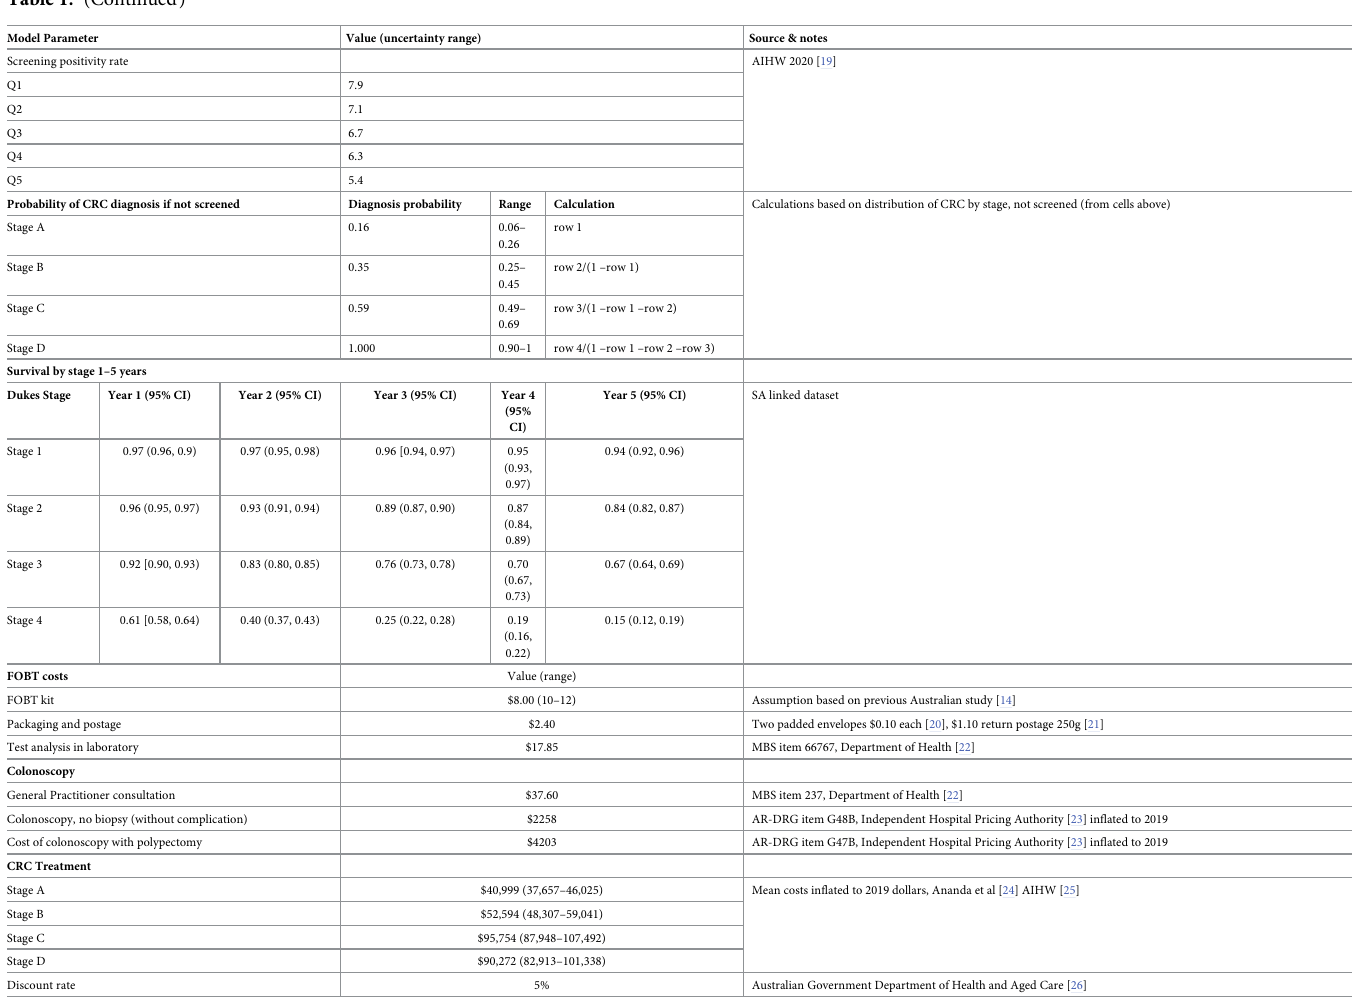
Colorectal cancer model. The first component of the modelling is the natural develop- ment of CRC, which influences the movement of patients to various health states. There are seven health states within the